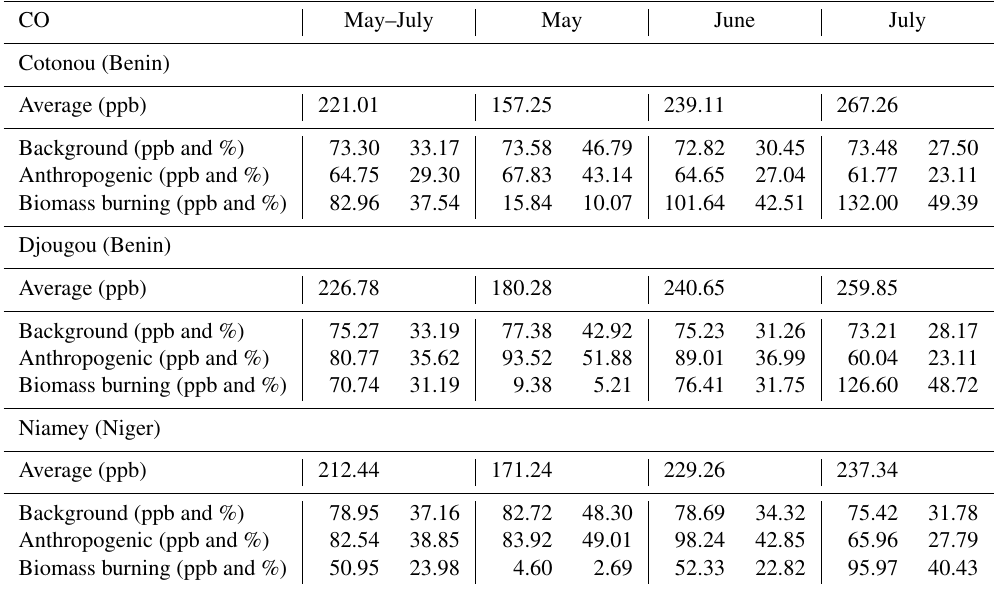
Table 2. CO (ppb) average and relative contributions (%) of each type of pollution source (background, anthropogenic, biomass burning) at Cotonou (Benin), Djougou (Benin) and Niamey (Niger). The time-averaged periods correspond to each month (May, June, July) and to the whole period (from May to